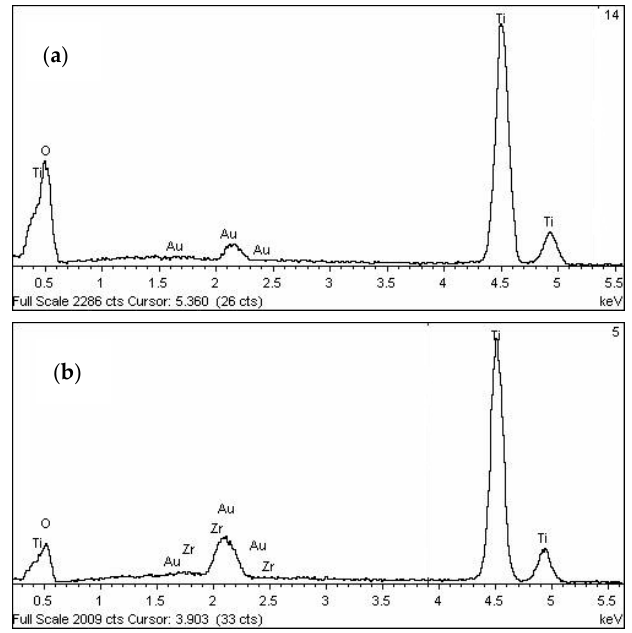
Figure 11. EDX analysis of T9 ( a ), and H ( b ), samples.